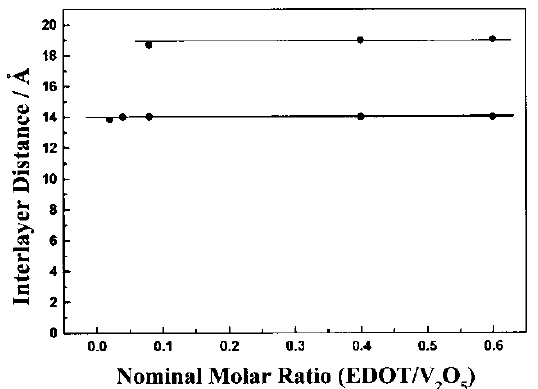
FIGURE 4 Evolution of interlayer distance upon increasing nominal molar ratio of EDOT to V 2 O 5